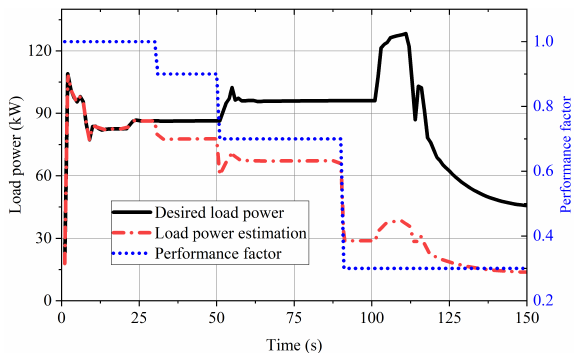
Figure 13. Waterjet load power estimation result.